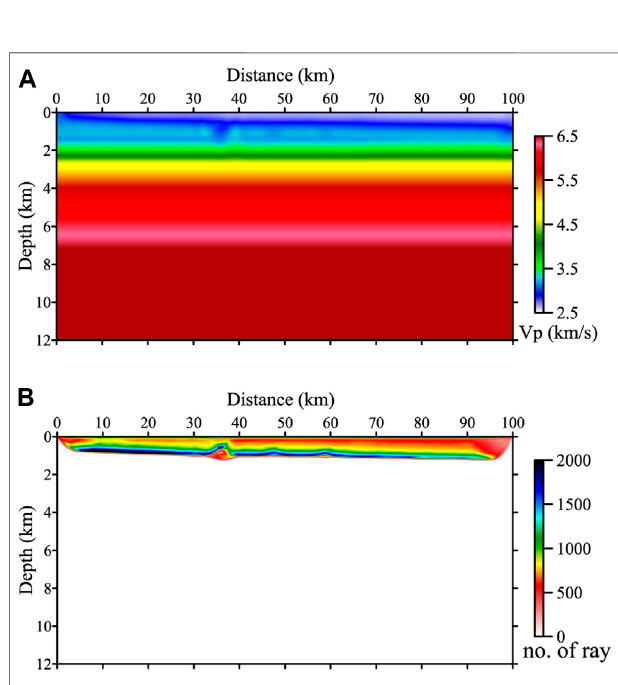
FIGURE 8 | The inverted velocity model (A) with a maximum offset of 10 km and (B) its ray density